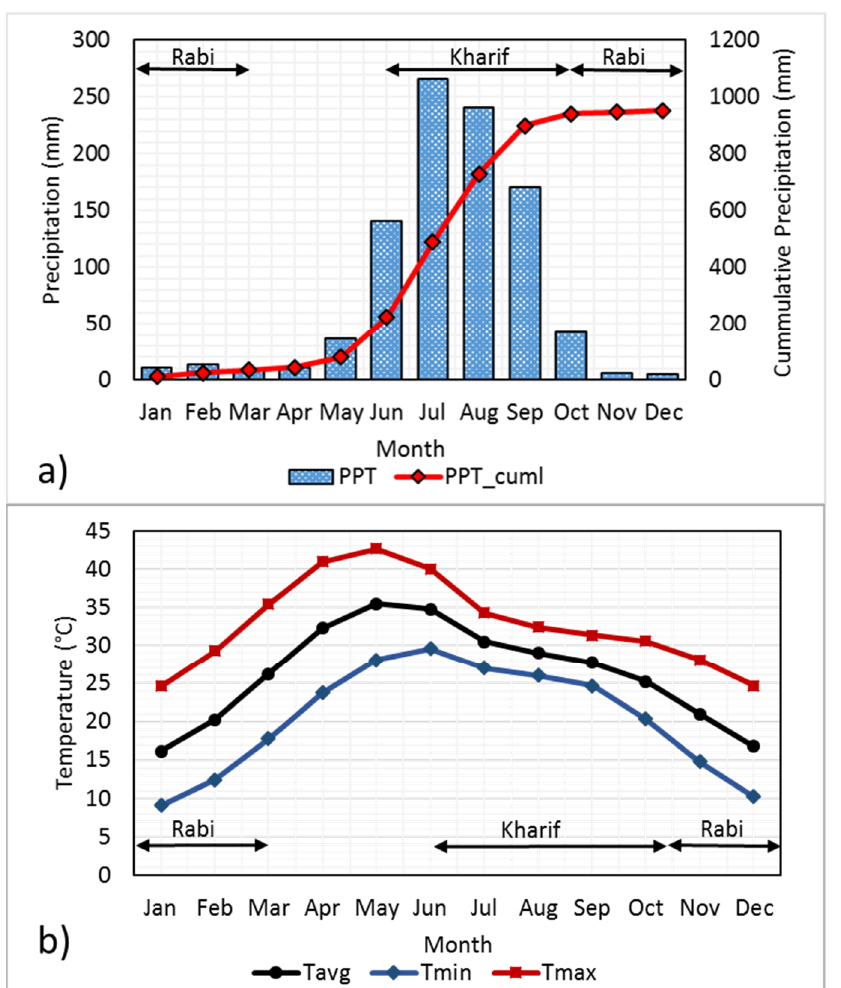
Figure 2. ( a ) Average monthly precipitation and cumulative rainfall ( b ) average, minimum and maximum monthly temperature highlighting the Kharif and Rabi season.